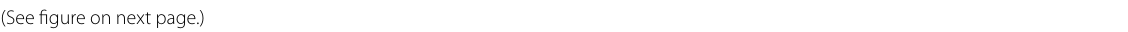
figure on next Fig. 3 Novel nomogram to predict the prognosis of NSCLC patients with ICIs treatment. A The survival curves for patients with ICIs treatment based on the ERBB4 mutational status; B The survival curves for patients with ICIs treatment based on the EGFR mutational status; C The survival curves for patients with ICIs treatment based on PD-L1 expression; D The survival curves for patients with ICIs treatment based on the tumor mutational burden (TMB); E The survival curves for patients with ICIs treatment based on treatment lines; F The survival curves for patients with ICIs treatment based on smoking history; G The novel nomogram based on these variables to predict the prognosis of ICI treatment; H The calibration plot for the